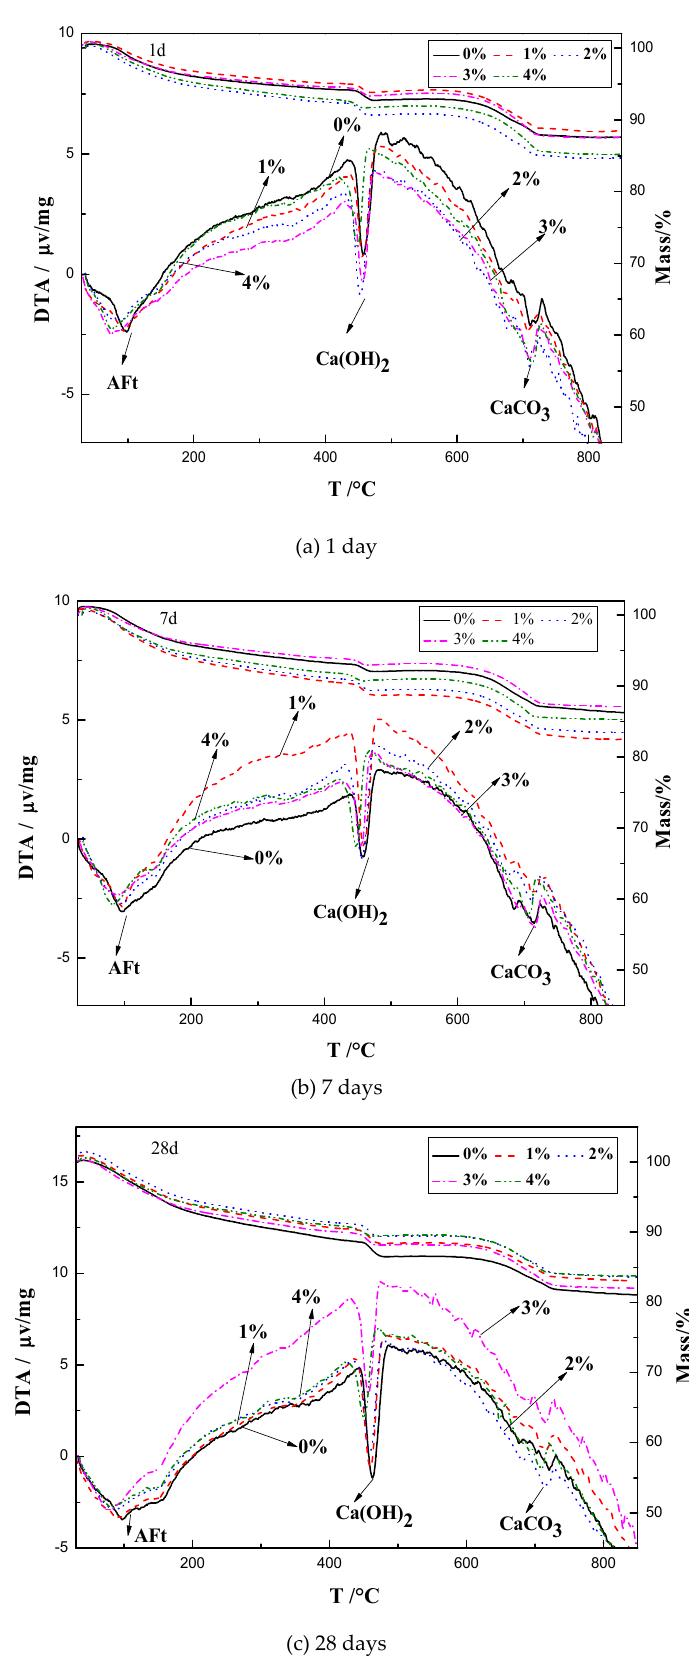
Figure 6. TG-DTA results of the pastes with different contents of Na 2 CO 3 at ages of ( a ) 1, ( b ) 7, and ( c ) 28